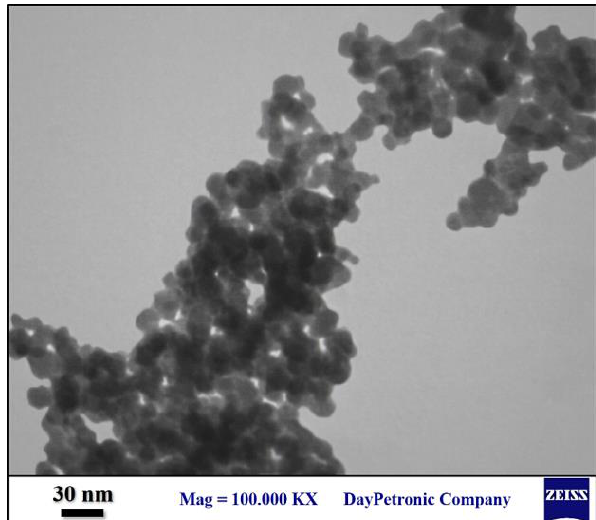
Fig. 2. TEM image of ZnFe Figure 2 : TEM image of ZnFe 2 O 4 nanoparticles.